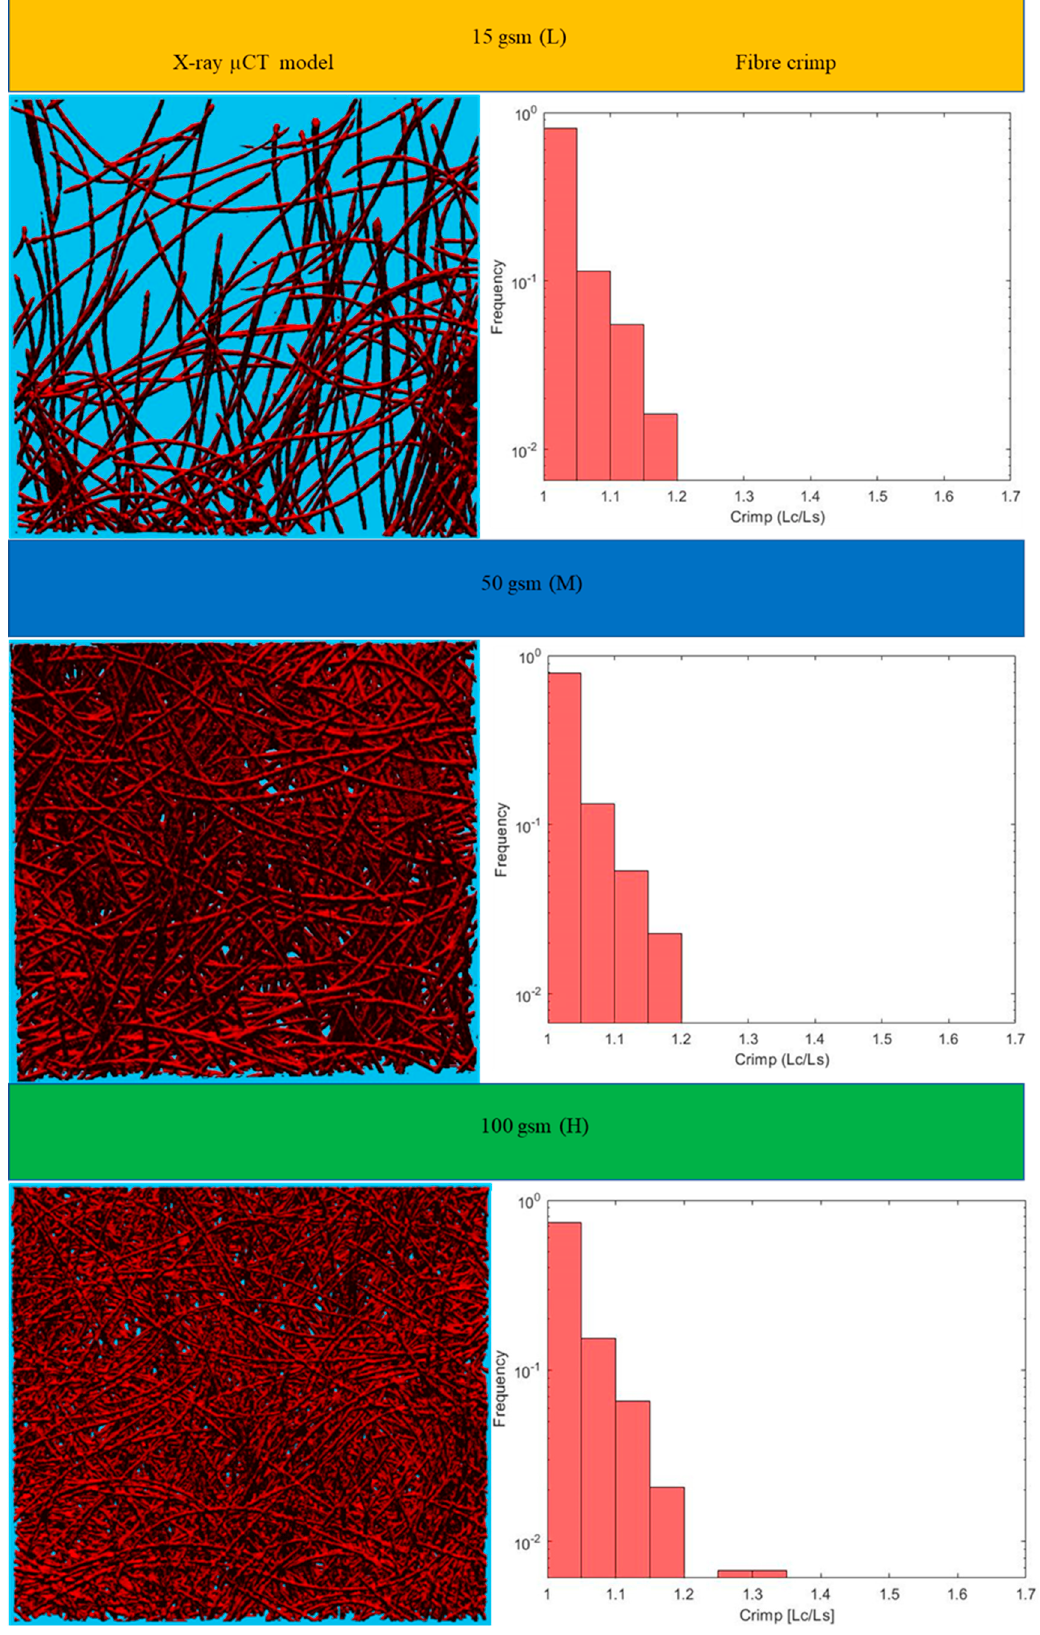
Figure 8. Distributions of 3D fibre crimp for fabrics with non-crimped fibres.